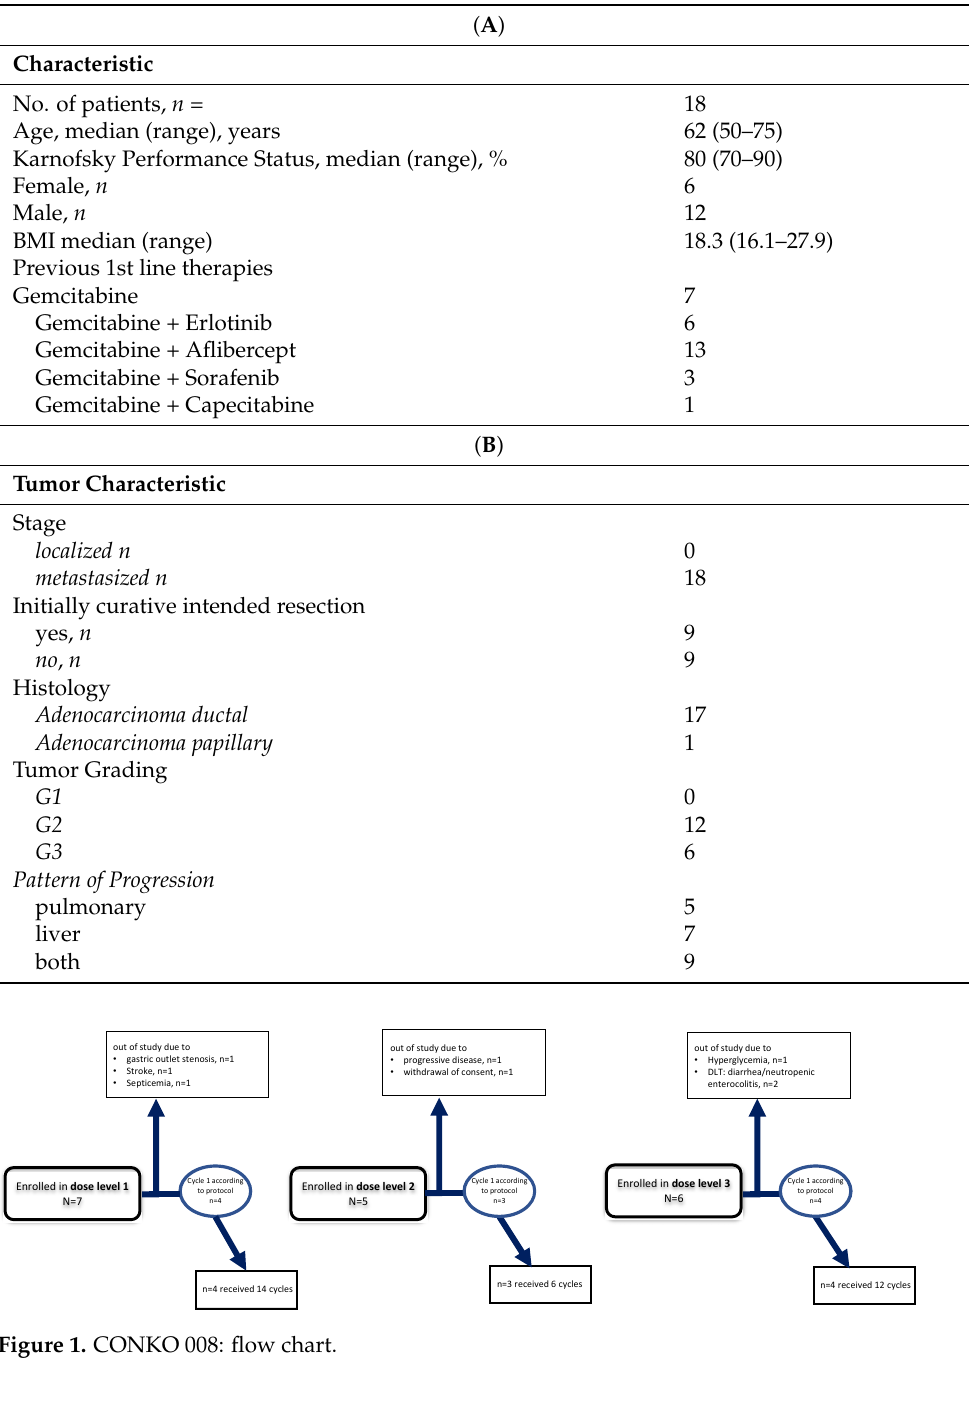
Table 1. ( A ) Baseline patient characteristics. ( B ) Baseline tumor characteristics.